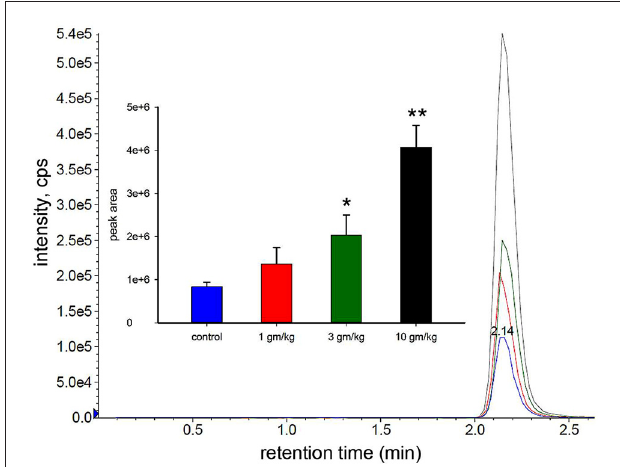
FIGURE 1 | Liquid chromatography-mass spectrometry (LC-MS/MS) analysis of N-acetylaspartate (NAA) in mouse brain after acute dosing with methyl ester of NAA (M-NAA). Typical LC-MS/MS scan results for the four groups (blue = control, red = 1 g/kg, green = 3 g/kg, black = 10 g/kg). Graph insert shows the peak areas for each group (means ± SD, n = 3 per group). Brain NAA levels in the 3 g/kg group were approximately 2.4 times those of controls which is similar to the levels found in aspartoacylase (ASPA) deficient mice ( ∗ p = 0.01, ∗∗ p = 0.0004, Student’s t -test, two tailed, two sample equal